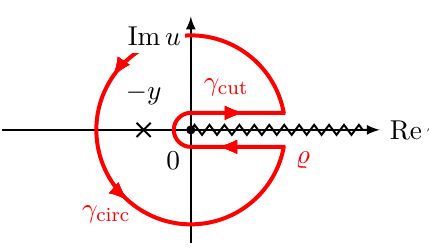
Figure 4 . The integration contour for (B.1). The integrand has a branch cut along the positive real u -axis if a is not integer, and an essential singularity at u = − y . The contour γ is the sum of a circle γ circ of radius % > y and of a Hankel-like contour γ cut wrapping the